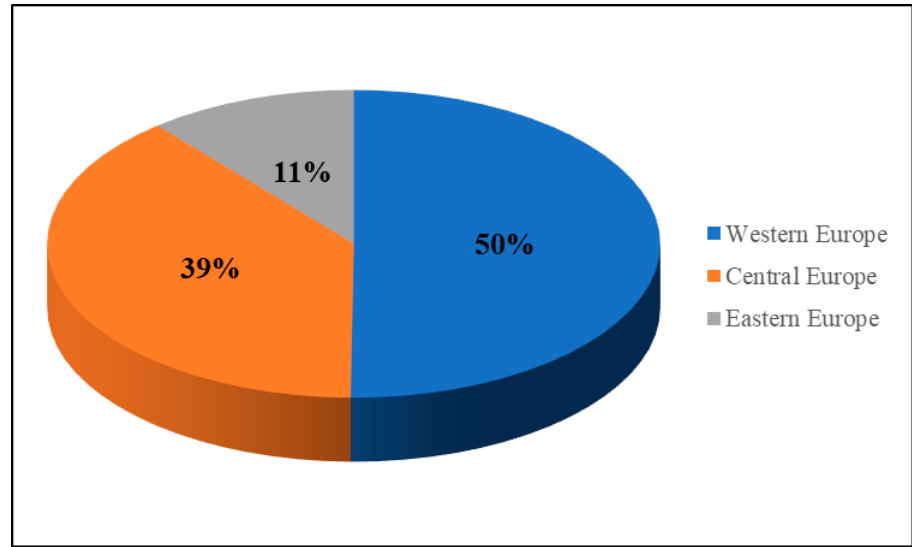
Figure 1. Total consumption per capita in European continent [1].